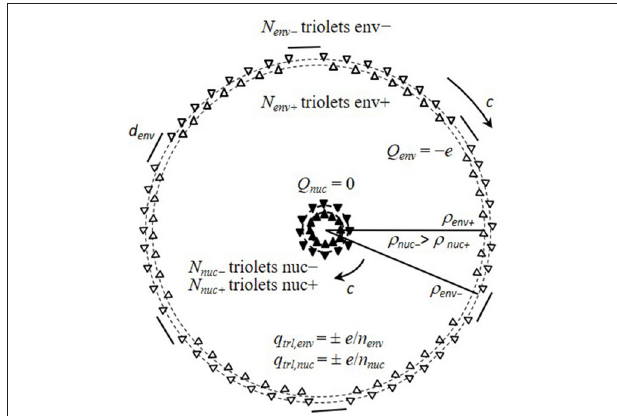
FIGURE 2 | Model of the electron at rest. In our simplified model, triolets rotate at light velocity in the same direction along four different coplanar circular orbits depending on their electric charge, constituting an envelope, and nucleus. Negative triolets are more numerous at the envelope, while the nucleus is neutrally charged. Due to the charged envelope, nucleus triolets are separated into two close orbits depending on their charge. Envelope triolets similarly revolve on separated orbits whose radii are close to the reduced Compton wavelength. Possible triolet configurations (triolet kinds and numbers, angular distributions, orbital radii) must fulfill constraints expressing radial stability and the measured values of charge, spin, magnetic moments, and mass. Due to consecutive negative triolets in the envelope, intertwined envelope triolets assemble into stretches separated by a distance d env